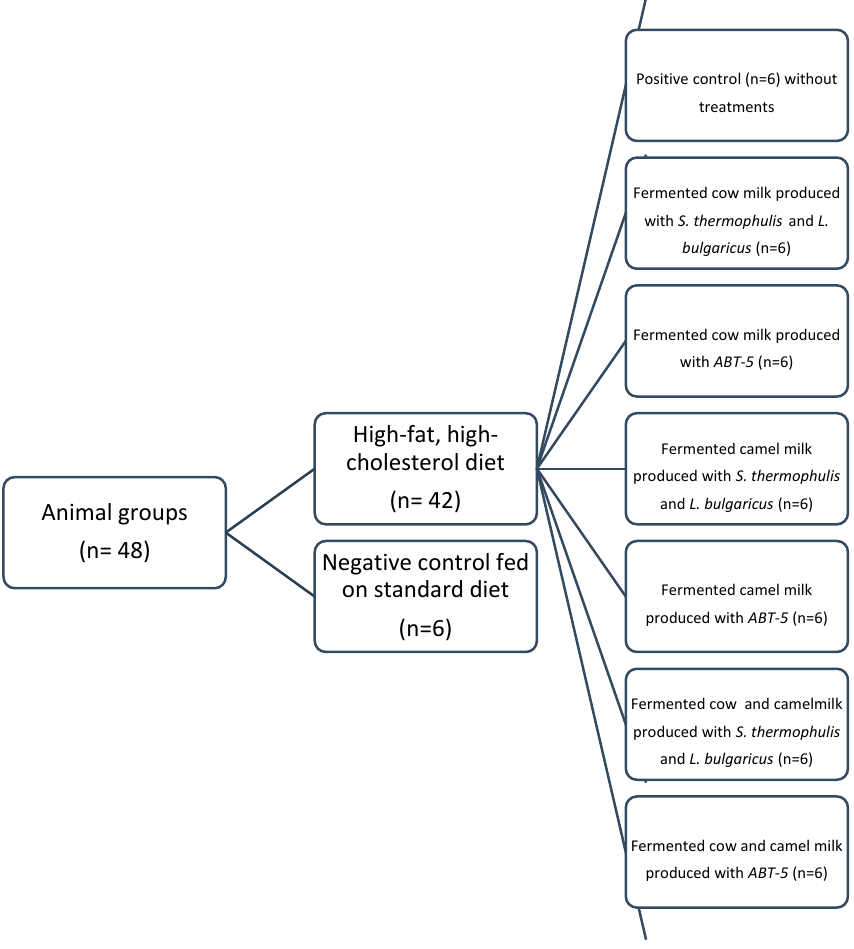
Figure 2. Diagram showing experimental design with animal groups.